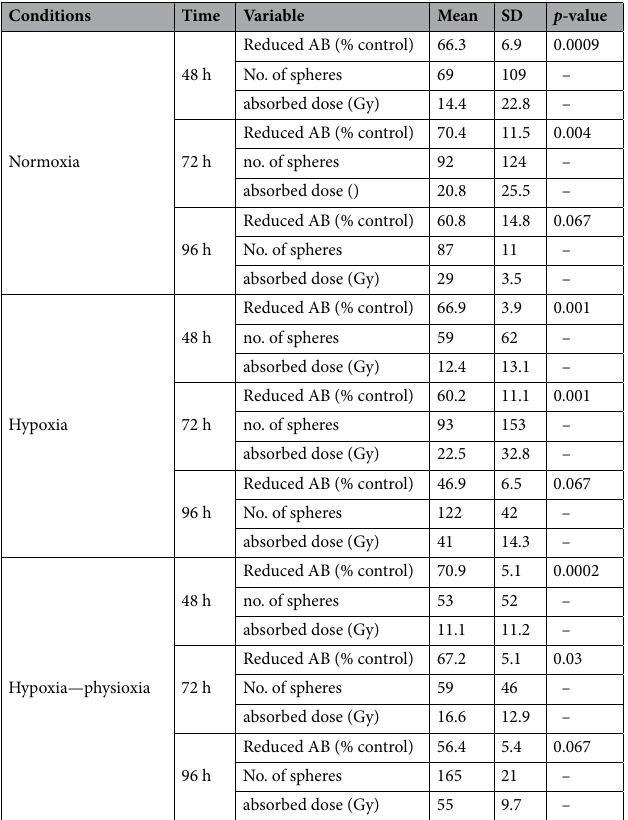
Table 1. Descriptive statistics for observations performed in various oxygenation conditions. AB Alamar Blue, SD standard deviation. Significance of reduced AB (% control) compared to that in relative control in subsequent time frames in different oxygen conditions. 1 Wilcoxon signed-rank test.